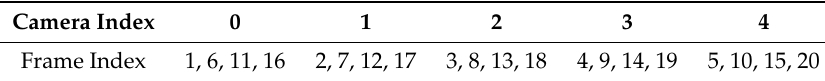
Figure 16. Estimated parameters by the proposed method and Pandey’s Mutual Information (MI) method [8] with different initial values as the numbers of frame increases. ( a – c ) Rotation angle along each axis; ( d – f ) Translation along each axis. Table 1. Relationship between the index of the frame and the index of the